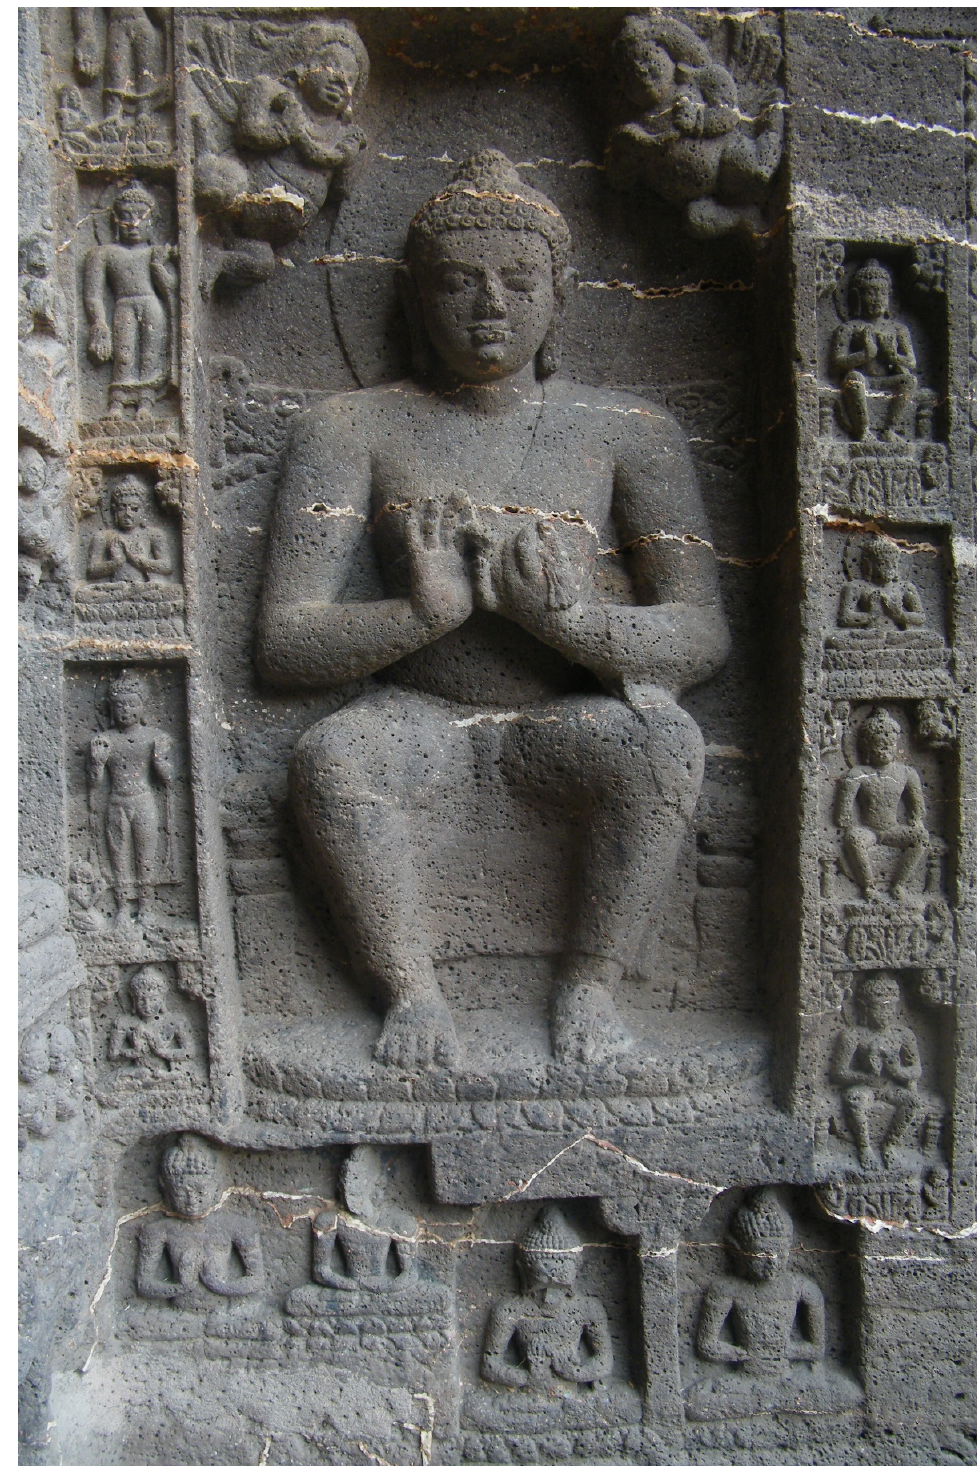
Figure 6. Intrusive panels from Aja ṇṭ ā Cave 19, ca. 478–480 CE (Photograph by the author).